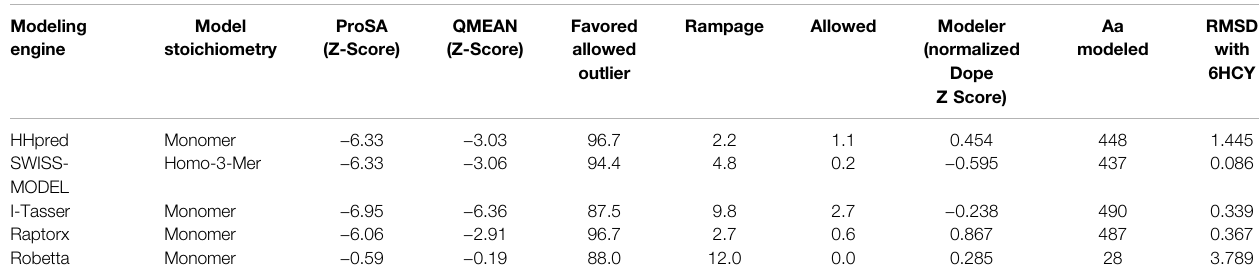
TABLE 3 | Structural evaluation of homology models by different validation